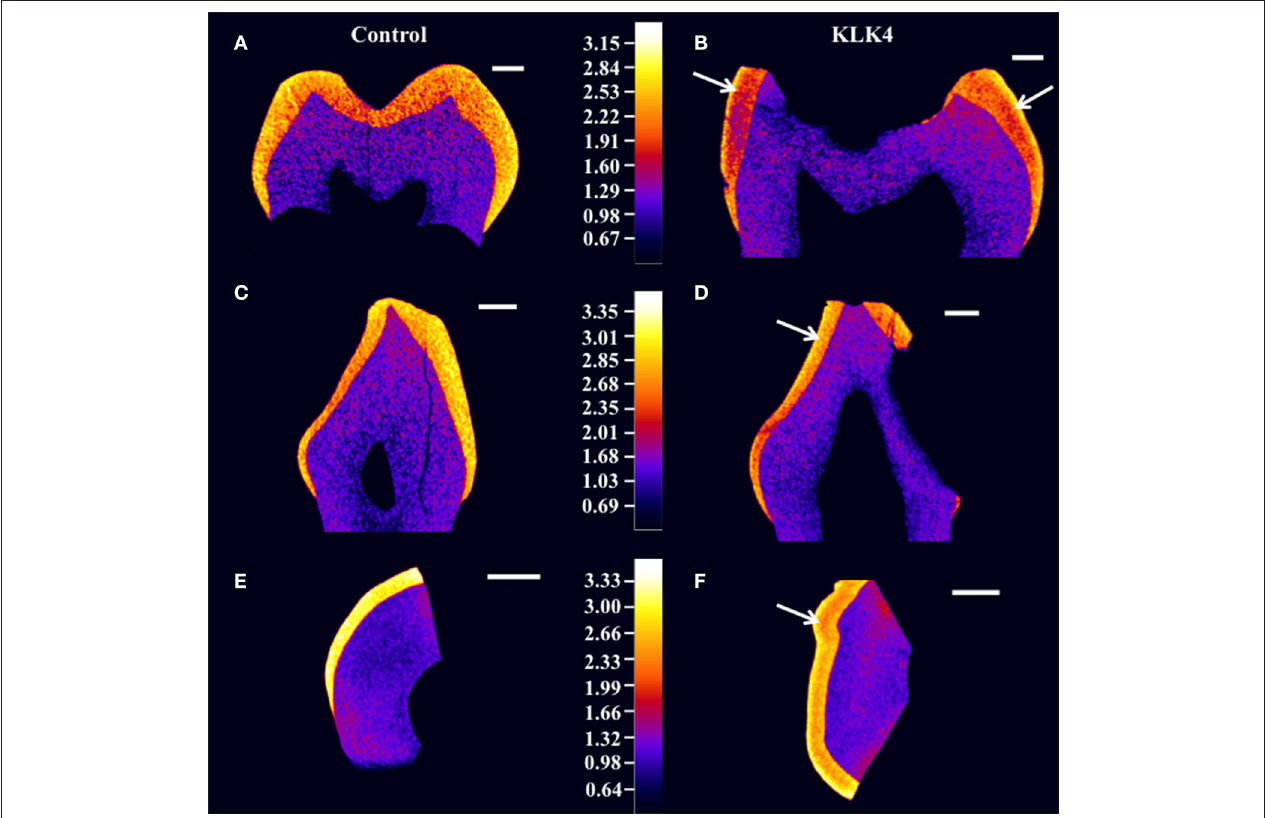
FIGURE 2 | High resolution X-ray CT analysis of WT control and KLK4 teeth from individual V:1 (family 1). (A,B) : molar teeth, (C,D) : canine teeth, (E,F) : incisal tooth slices. Arrows indicate the presence of an inner layer of enamel of lower mineral density not seen in control teeth. Scale bars represent 1